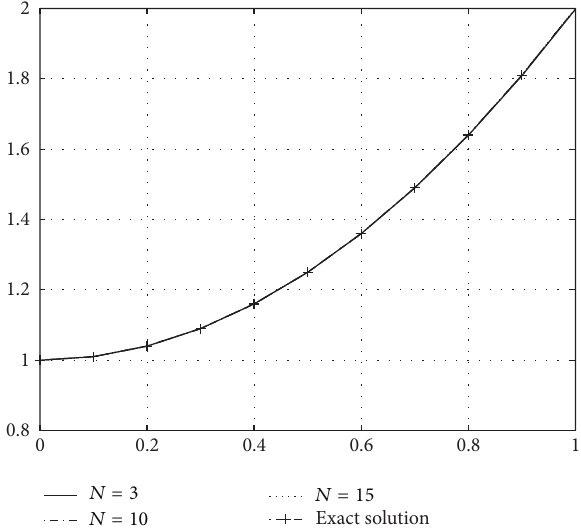
Figure 1: Numerical and exact solution of Example 4 for 𝑁 = 3, 10, 15